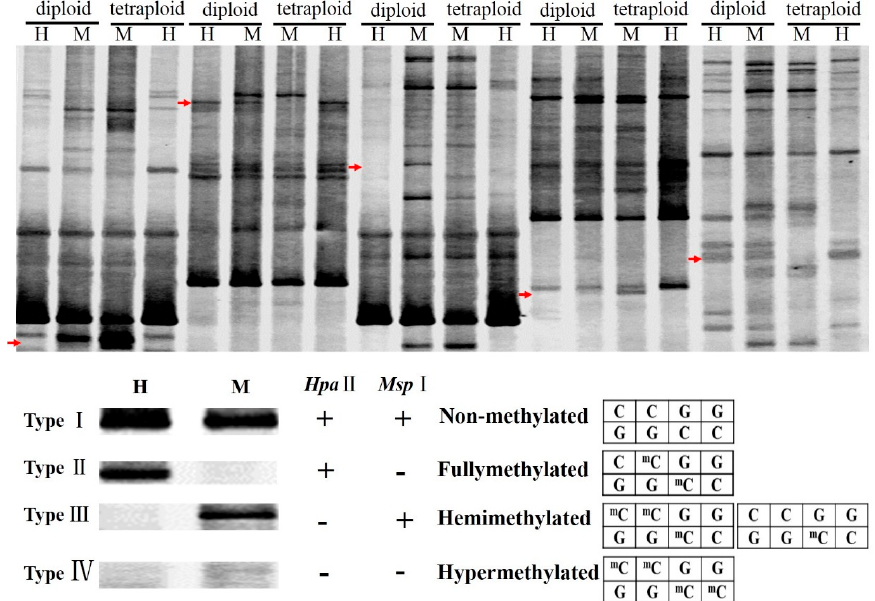
Figure 4. Representative variation in MSAP profiles. “ → ” to red arrows represents variation in DNA methylation between diploid and tetraploid plants; “+” represents fragments obtained after digestion with EcoR I or Hpa II/ Msp I; “ − ” represents fragments not digested by EcoR I or Hpa II/ Msp I; Type I fragments are nonmethylated and were presented in both the H ( EcoR I or Hpa II digest) and M ( EcoR I or Msp I digest) lanes; Type II are fully methylated and only appeared in the M lanes; Type III are hemimethylated and appeared in the H lanes; Type IV were fragments absent from both H and M lanes in diploid but present in either H or M lane of tetraploid, and vice versa.